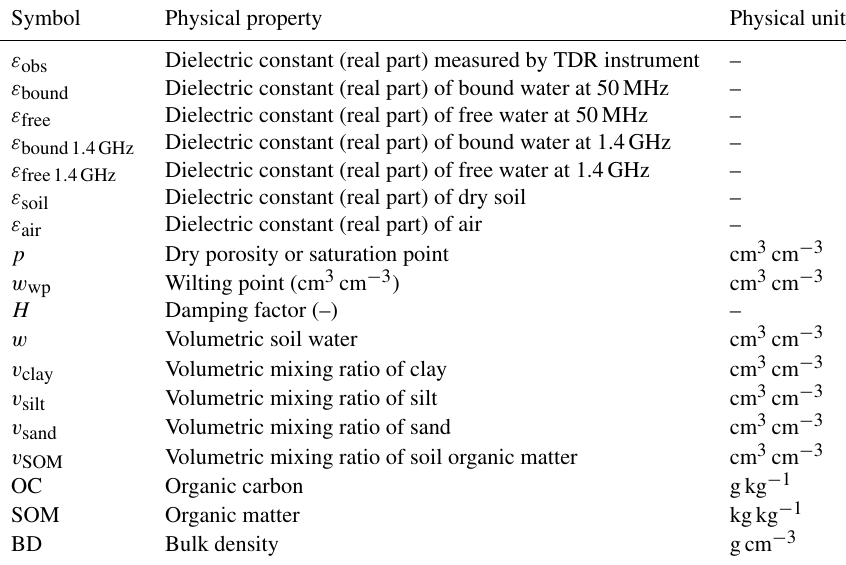
Table 1. Required physical properties to inverse the dielectric mixing model. Symbol Physical property Physical unit ε obs Dielectric constant (real part) measured by TDR instrument – ε bound Dielectric constant (real part) of bound water at 50MHz – ε free Dielectric constant (real part) of free water at 50MHz – ε bound1 . 4GHz Dielectric constant (real part) of bound water at 1.4GHz – ε free1 . 4GHz Dielectric constant (real part) of free water at 1.4GHz – ε soil Dielectric constant (real part) of dry soil – ε air Dielectric constant (real part) of air – p Dry porosity or saturation point cm 3 cm − 3 w wp Wilting point (cm 3 cm − 3 ) cm 3 cm − 3 H Damping factor (–) – w Volumetric soil water cm 3 cm − 3 v clay Volumetric mixing ratio of clay cm 3 cm − 3 v silt Volumetric mixing ratio of silt cm 3 cm − 3 v sand Volumetric mixing ratio of sand cm 3 cm − 3 v SOM Volumetric mixing ratio of soil organic matter cm 3 cm − 3 OC Organic carbon gkg − 1 SOM Organic matter BD Bulk